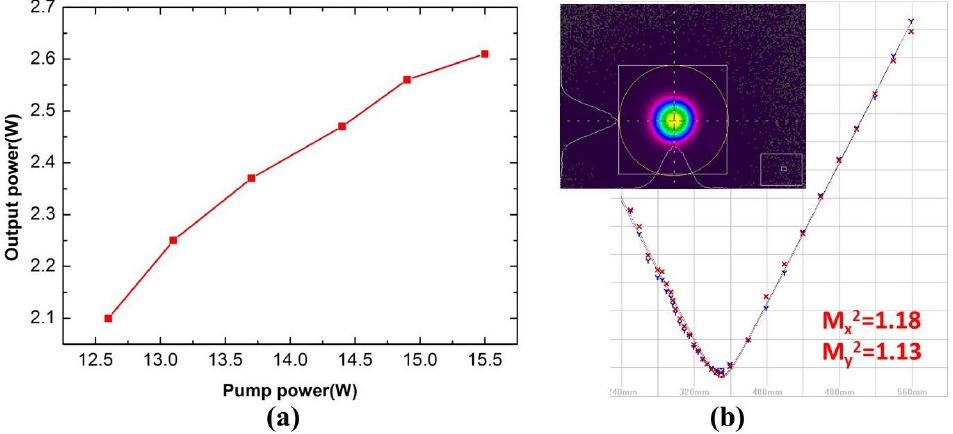
Figure 11. ( a ) Power curve of regenerative amplification; ( b ) Beam quality of the output pulses from the regenerative